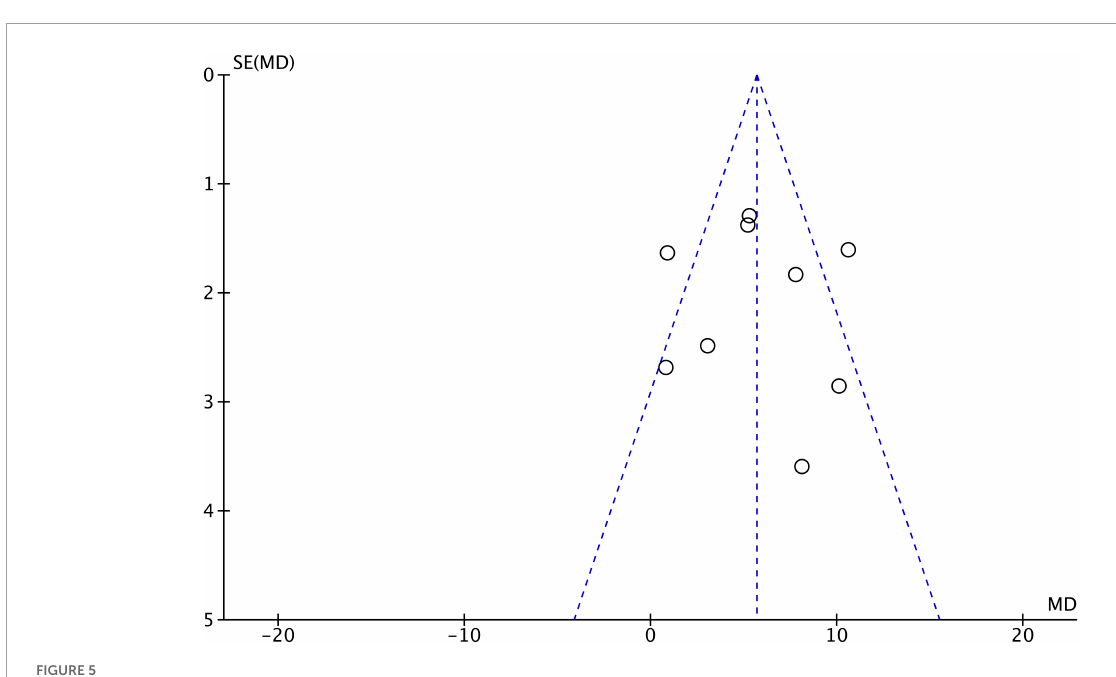
FIGURE5 Funnel plot of publication bias.